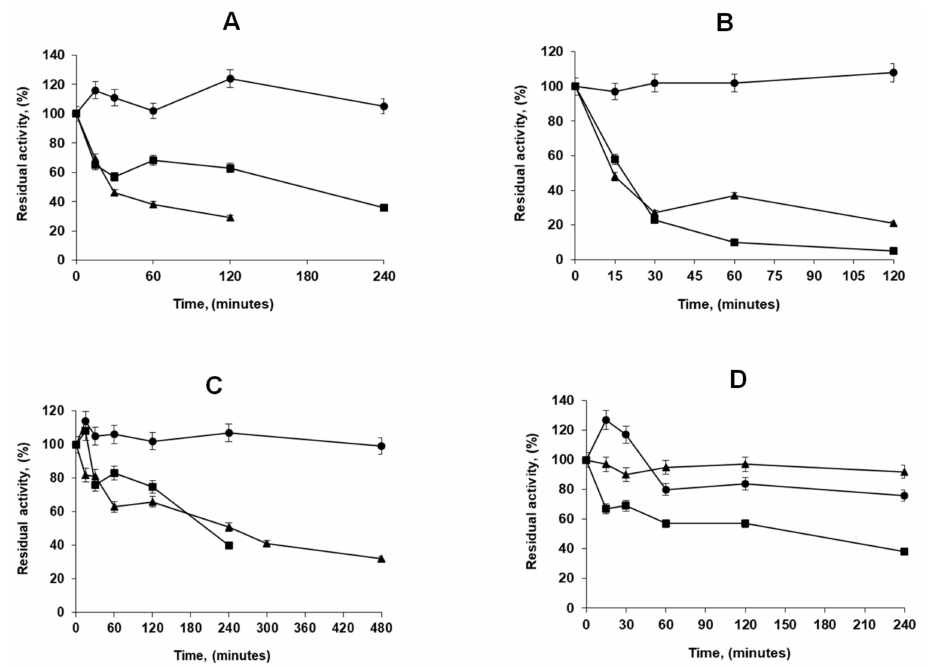
Figure 4. Inactivation profiles of di ff erent lipase preparations incubated under di ff erent conditions.: in the presence of 40% ( v / v ) acetonitrile at 25 ◦ C ( A ); in 30% ( v / v ) acetonitrile at 30 ◦ C ( B ); in 40% ( v / v ) 1,4-dioxane at 25 ◦ C ( C ); and 30% ( v / v ) 1,4-dioxane at 30 ◦ C ( D ). The experiments were carried out at pH 7. Other specifications are described in Methods. Solid circles: octyl-PFL; solid triangles: octyl-RML; and solid squares: